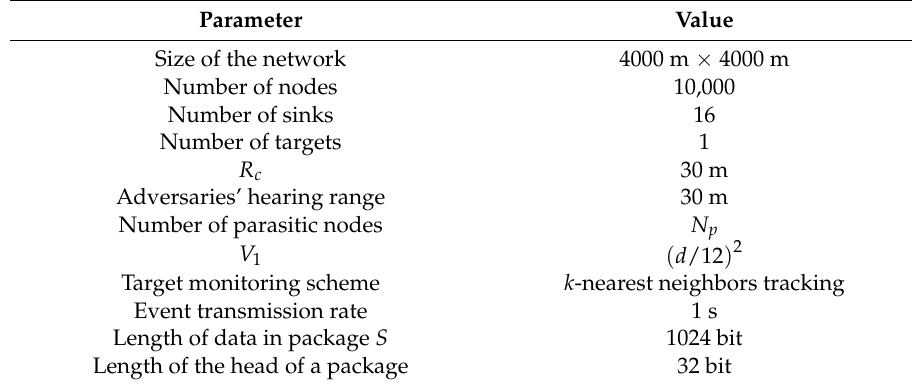
Table 1. Simulation